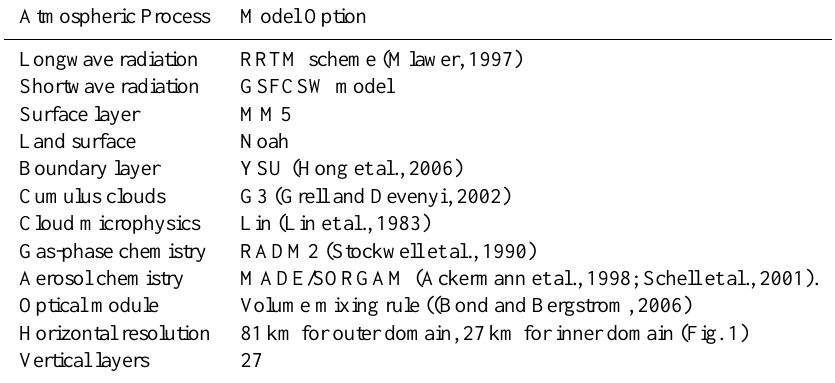
Table 1. Configuration options employed by WRF-Chem in this